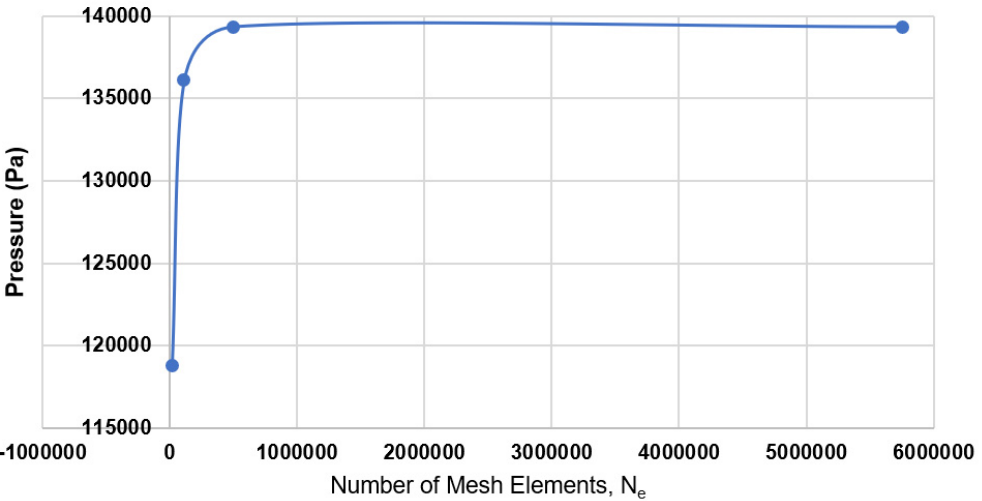
Figure 7. Mesh convergence study showing relationship between pressure and number of elements in 3D.